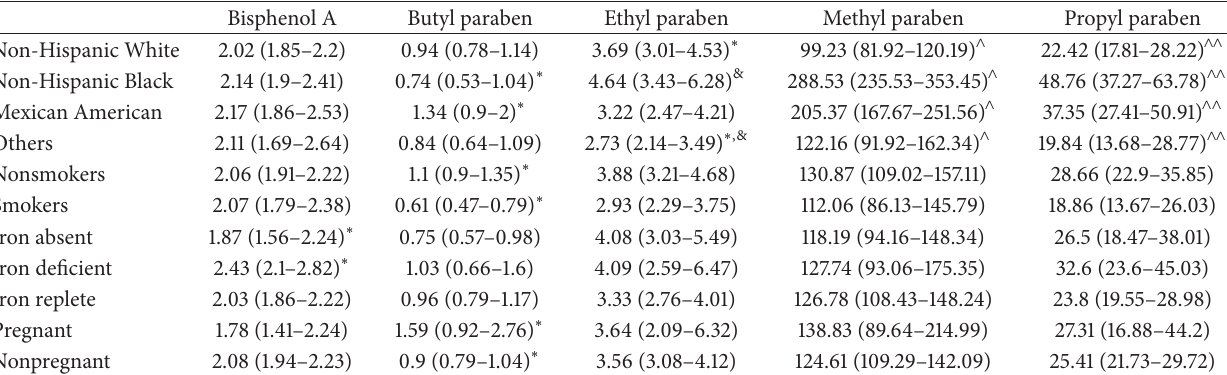
Table 5: Adjusted geometric means in ng/mL with 95% confidence intervals for selected endocrine disrupting chemicals for females aged 20–44 years. Data from the National Health and Nutrition Examination Survey 2003–2010 #